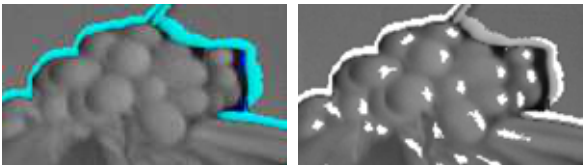
Figure 9: Original range image with highlighted areas arising from multiple echoes (left) and regional maxima overlapped on original image (right).